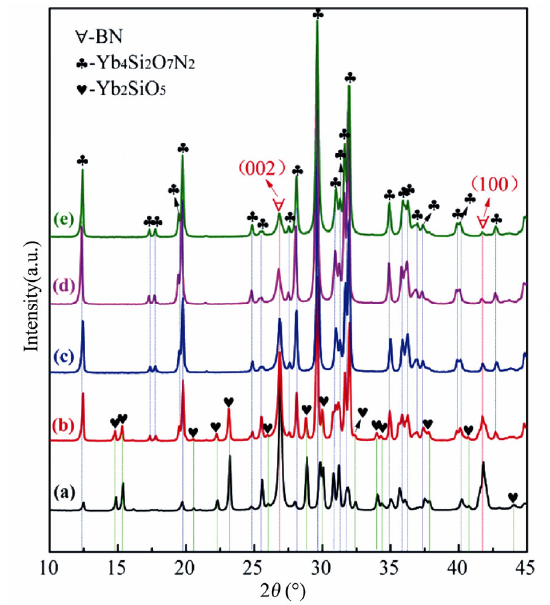
Fig. 1 XRD patterns of h -BN/Yb 4 Si 2 O 7 N 2 composites: (a) BYb10, (b) BYb20, (c) BYb30, (d) BYb40, and (e)